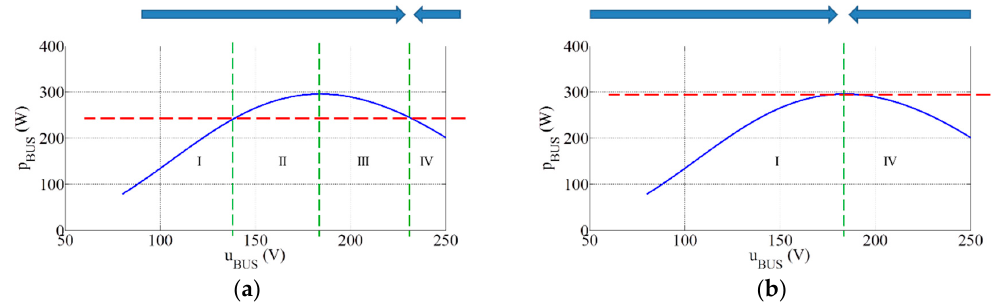
Figure 5. Power controlling strategies.